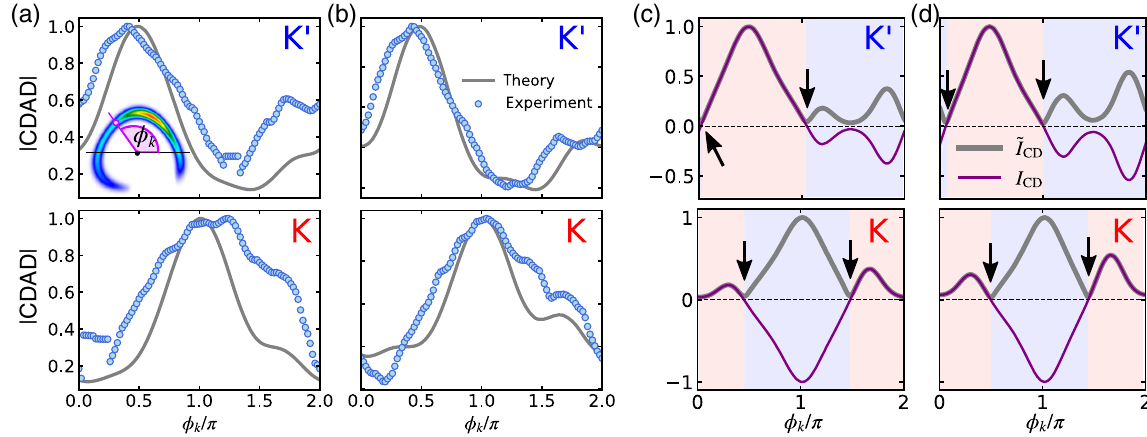
FIG. 5. Circular dichroism without circular photons. (a,b) Absolute value of the CDAD extracted from the experimental data and − 0 . 18 eV (a) and E − E − 0 . 25 eV (b), as a function of the angle ϕ theory via Eq. (9) at fixed binding energy E − E VBM ¼ VBM ¼ tracing the intensity. The inset illustrates how the angle ϕ is measured along the contour of maximum intensity. (c,d) Theoretical k ˜ I E; k Þ ] and calculated CDAD [ I E; k Þ ] as in (a,b). The arrows indicate the kink positions that can be used to reconstructed [ CD ð CD ð determine sign changes (indicated by the shaded